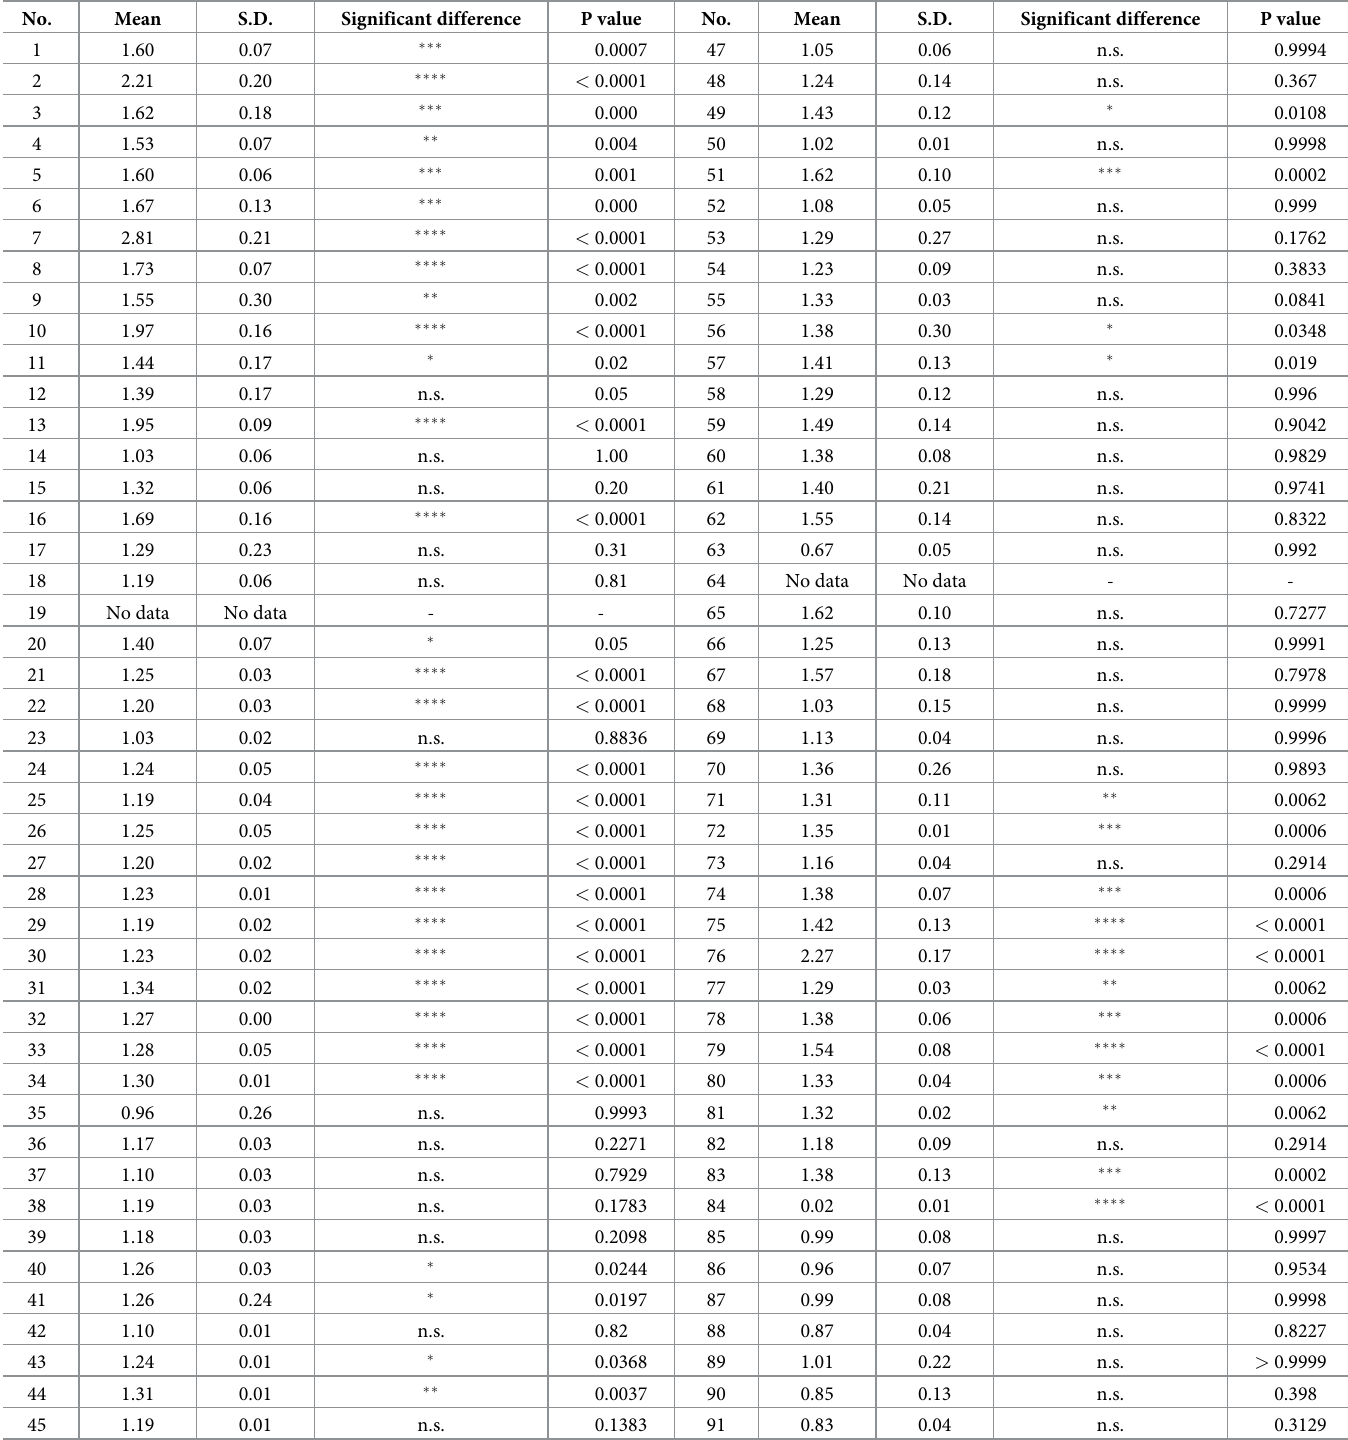
Table 2. A summary of Sema3A reporter gene activity by herbal plant extracts.